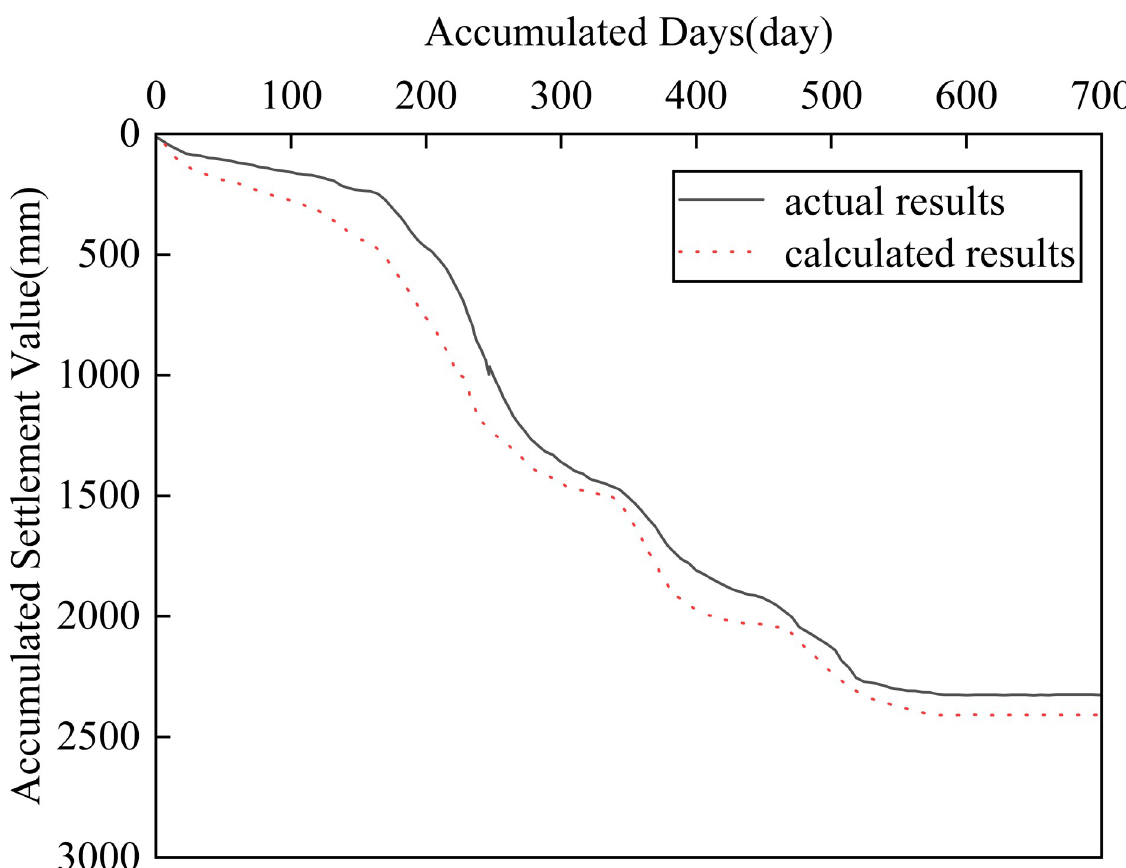
Fig 6. Settlement-time curve of the center of the subgrade